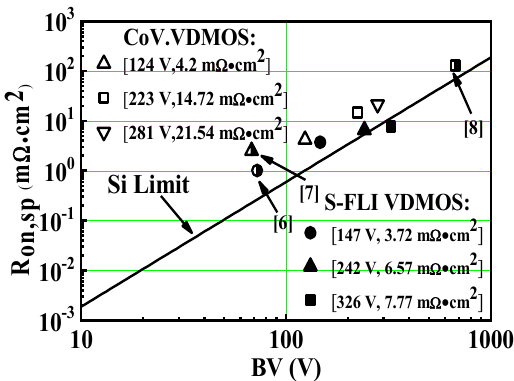
Figure 7. ( a ) Output characteristics and ( b ) transfer characteristics of the conventional Si VDMOS and S-FLI VDMOS.